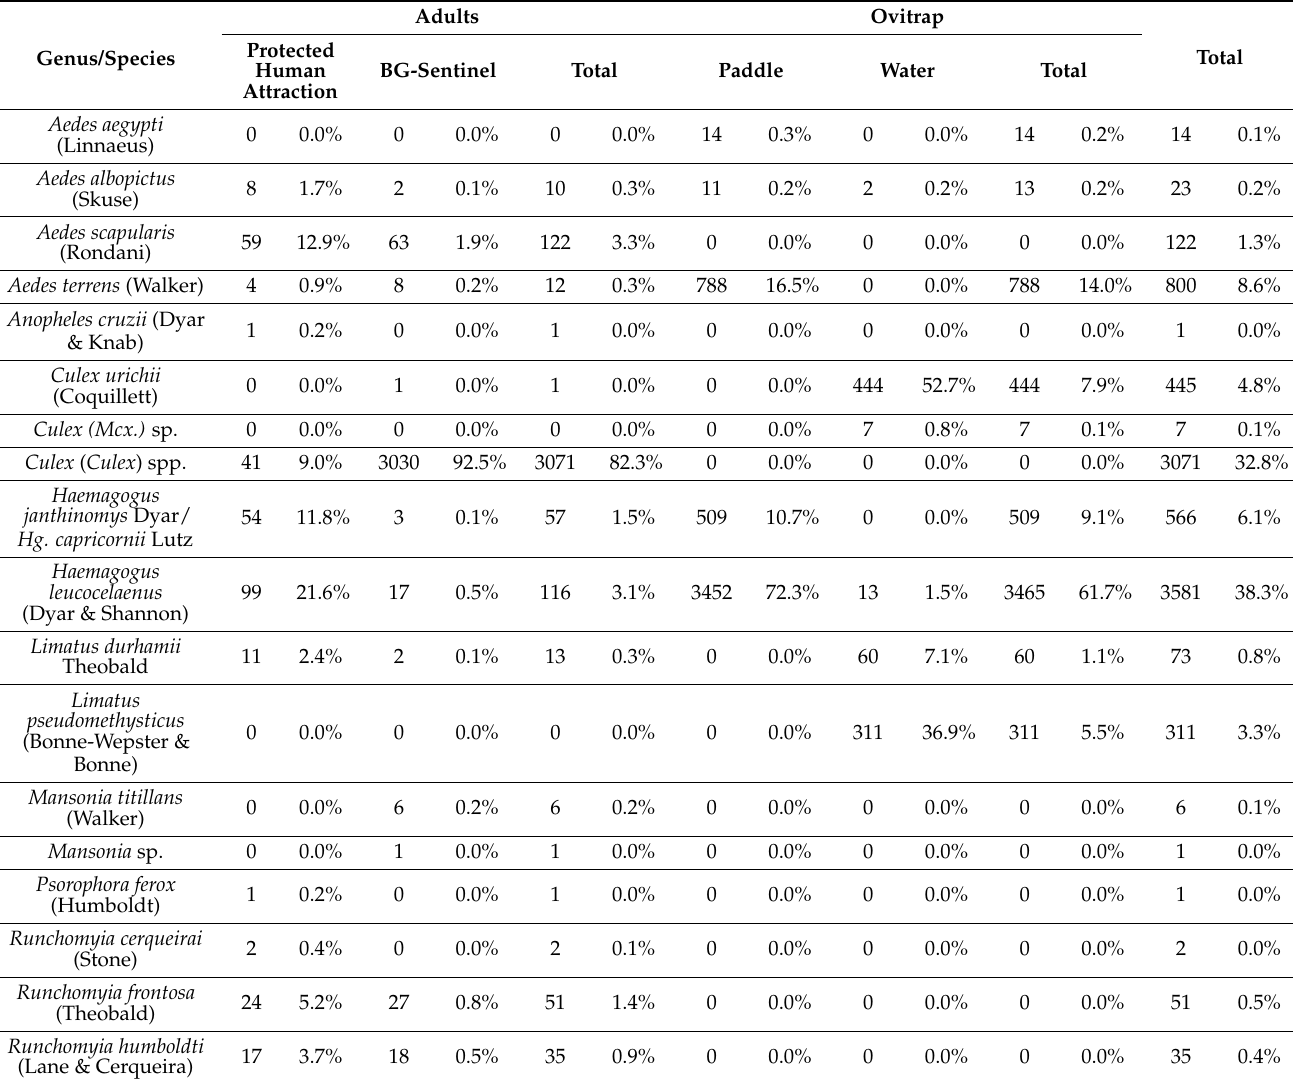
Table 1. Number and percentage of mosquito specimens collected across all sampling points and capturing methods at the Centro de Primatologia do Rio de Janeiro from December 2018 to Decem- ber